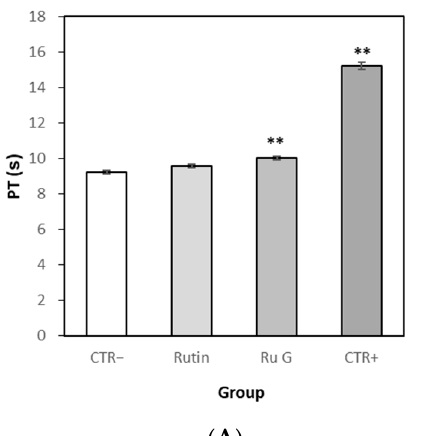
Figure 7. The aggregation rates of platelet-rich plasma (PRP) in vitro. Each time point represented the mean ± S.E. ( n = 3). CTR − ; normal control (distilled water), CTR+; positive control (aspirin), Ru G; rutin glycoside. Significant differences from the normal control group were identified using Independent t -test (** p < 0.01).